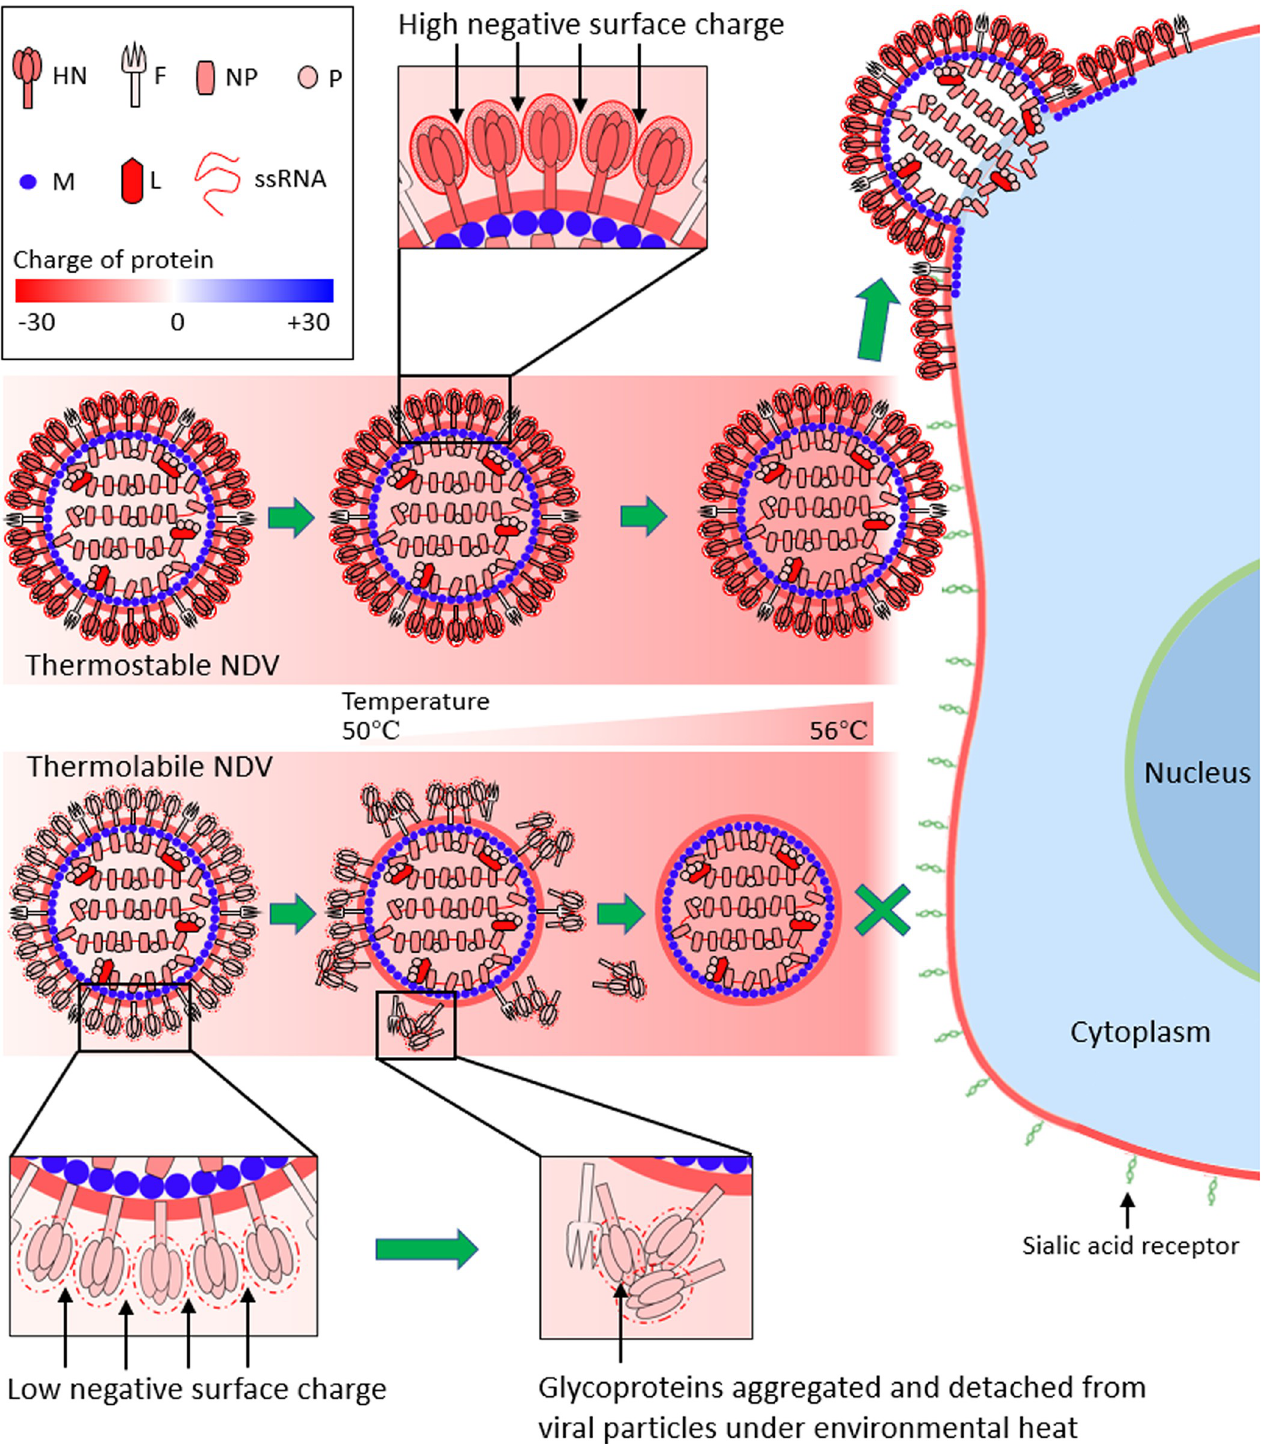
Fig 8. Proposed model for the surface charge of HN protein as “the key determinant” for the thermostability of NDV. The negative surface charge of HN from thermostable NDV is considerably higher than that of HN from thermolabile NDV. The first step of NDV infection is the binding of HN with the sialic acid receptor of the host cells. When thermolabile virion is subjected to environmental heat, HN proteins with low negative surface charge tend to aggregate, and detach from viral particles. Then the naked viral particles can-not bind to the cell receptors and the viral infection does not occur. However, when the thermostable virion is subjected to heat, HN proteins with high negative surface charge do not aggregate, and remain evenly distributed on the viral particles. This allows the initiation of infection and complete cycle of viral replication.